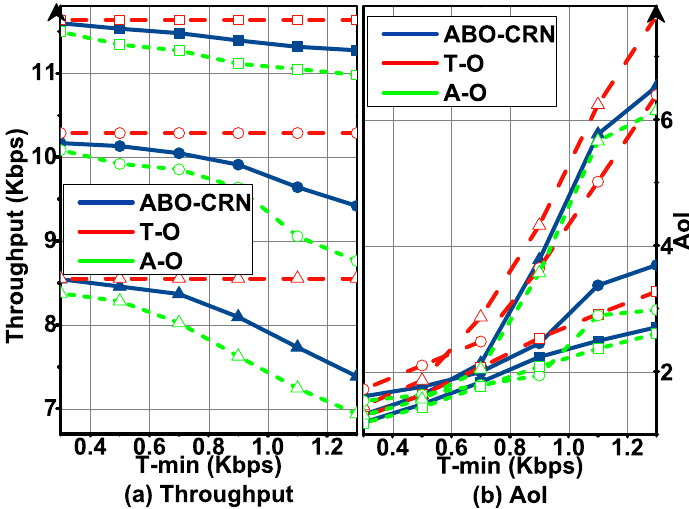
Figure 6. Throughput T and AoI versus T min under P a = 0.3 (circle), 0.6 (square), 0.9 (triangle) compared with that of T-O and A-O baseline schemes, and A max = 5: ( a ) describes the throughput performance. ( b ) describes the AoI